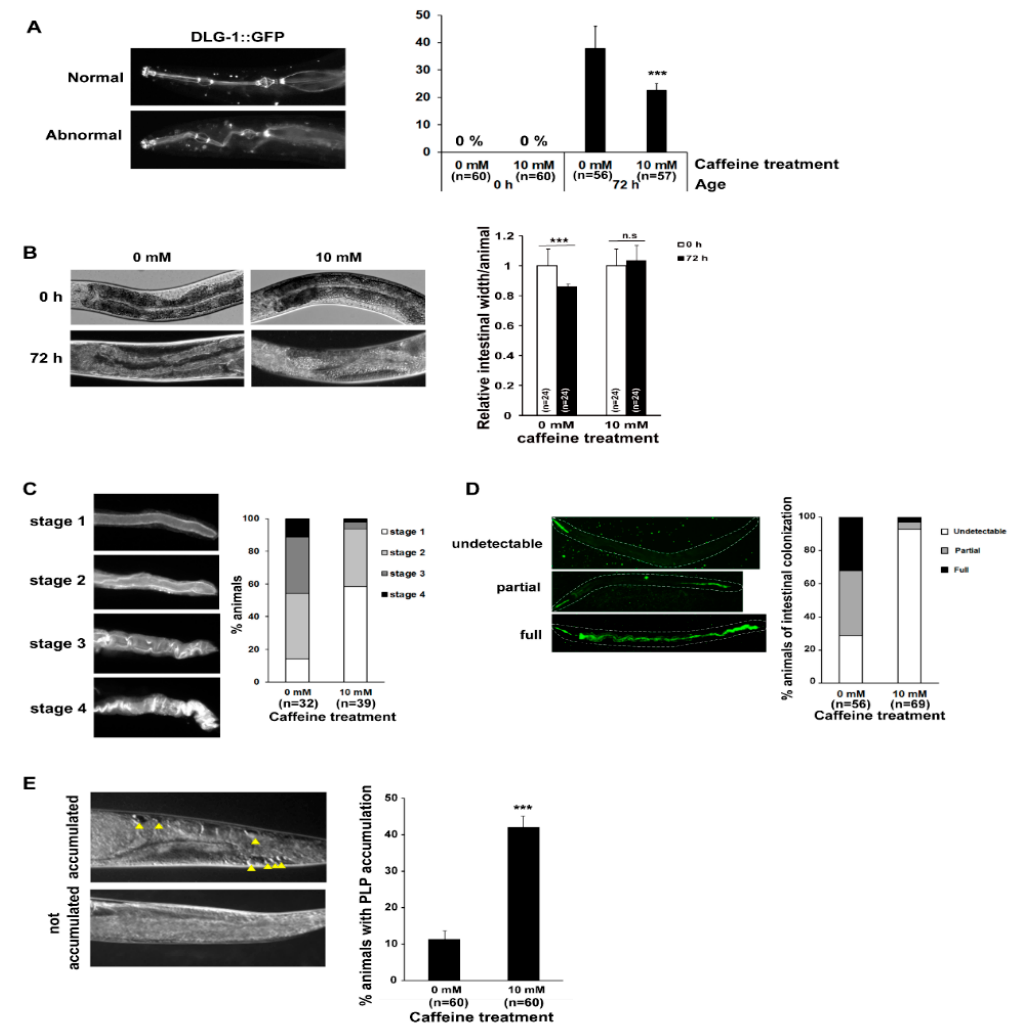
Figure 1. Long-term caffeine intake delays intestinal aging during advanced ages of Caenorhabditis elegans : ( A ) Animals expressing discs large MAGUK scaffold protein 1 (DLG-1):: green fluorescent protein (GFP) were treated with 0 or 10 mM caffeine at the L4 stage at 25 ◦ C for 72 h. The location of DLG-1::GFP in the pharynx was observed at 72 h post-L4 stage